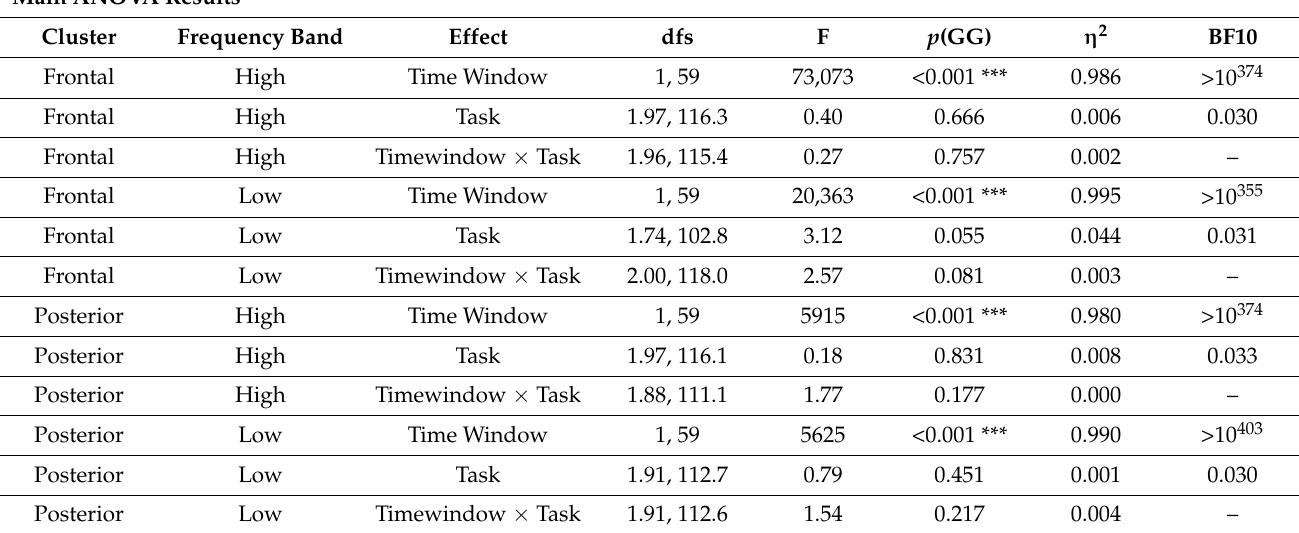
Table 1. Results from the task × time window ANOVAs across the different electrode clusters and frequency bands. Note that for the main effect of the task and the task-by-time-window interaction, we report the corrected degrees of freedom and p -values. No sphericity correction was necessary for the main effect of the time window since it only has two levels. When marking significance, *** denotes p <